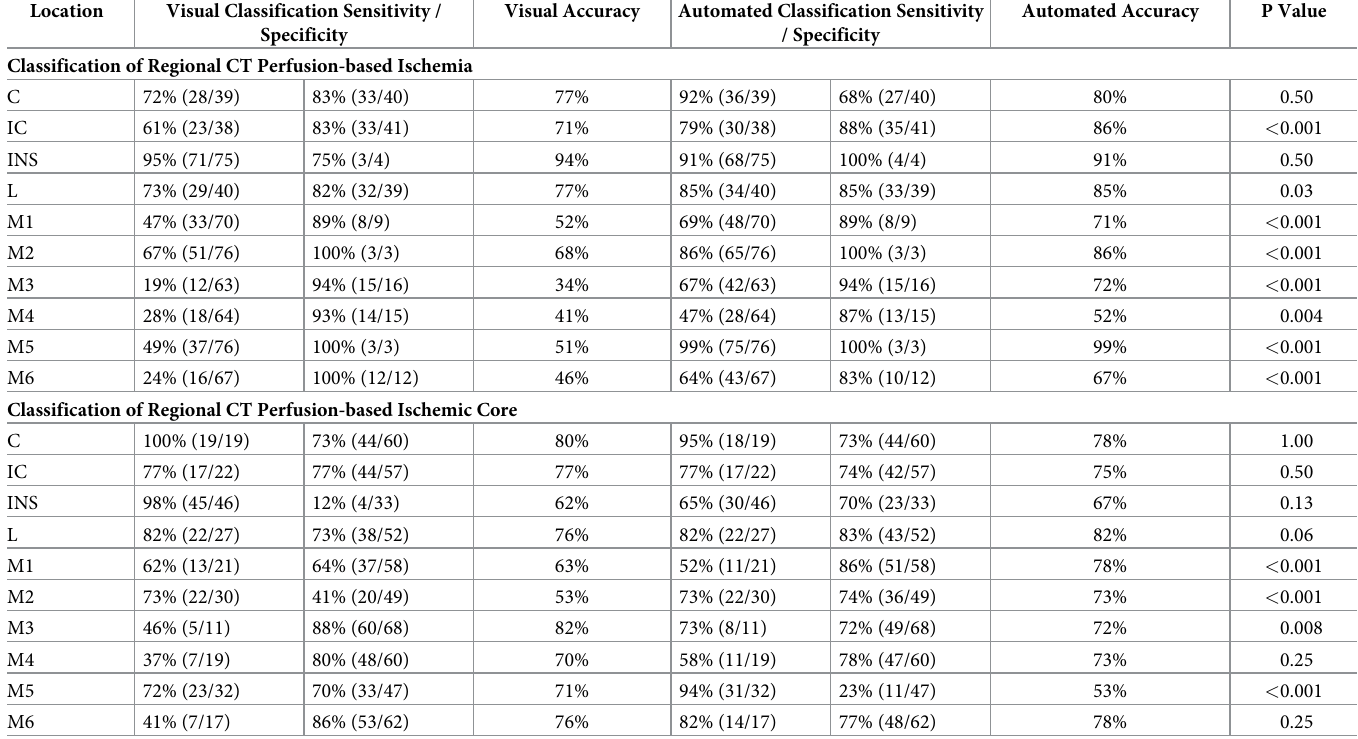
Table 5. Comparison of visual and automated analysis of CTASI and for the classification of regional ischemia and ischemic core. Location Visual Classification Sensitivity /